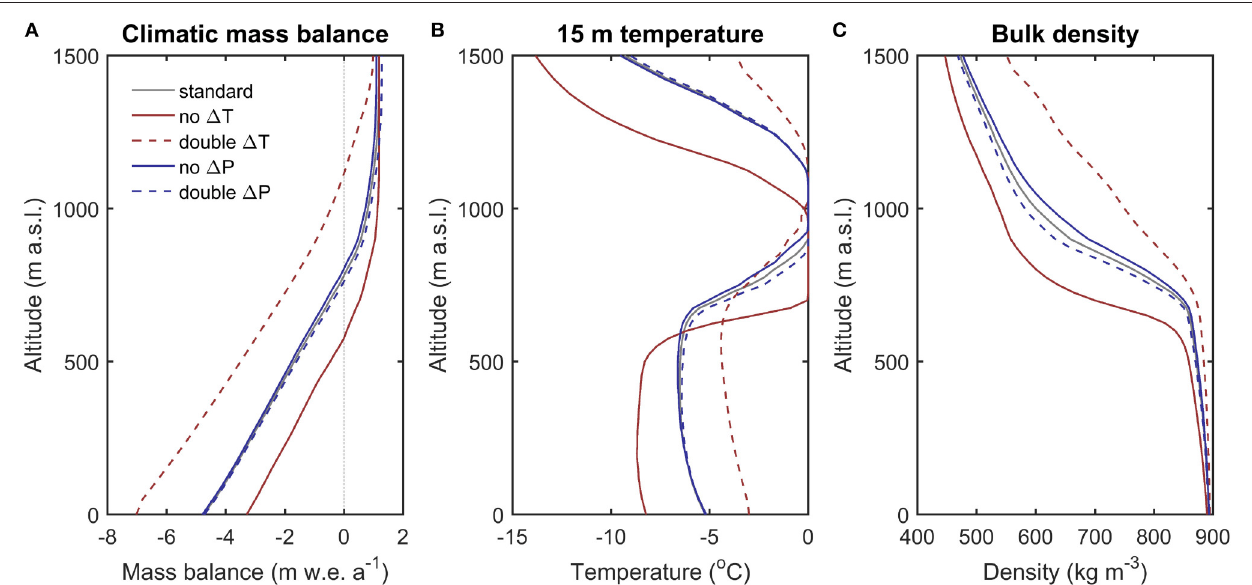
FIGURE 8 | Sensitivity of the 2014–2104 mean climatic mass balance (A) , 15-m subsurface temperature (B) and the 0–10m bulk density (C) for a range of future climate scenarios.